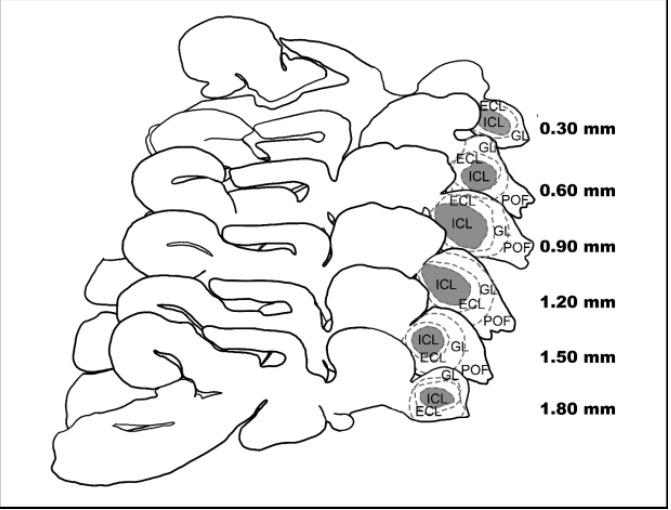
Figure 2. Sagittal slices of the eel’s brain. Representation of the sagittal slices of a male Silver eel’s brain. The ICL (grey area) of the left OB is included.